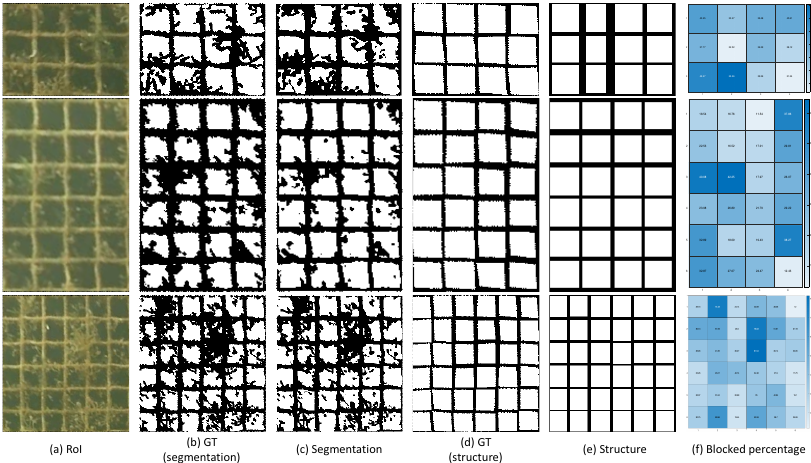
Figure 12. Qualitative evaluation on real scenes. ( a ) RoI; ( b ) segmentation ground-truth; ( c ) segmentation results; ( d ) structure (rectangle) ground-truth; ( e ) structure results; and ( f ) blocked percentage results.